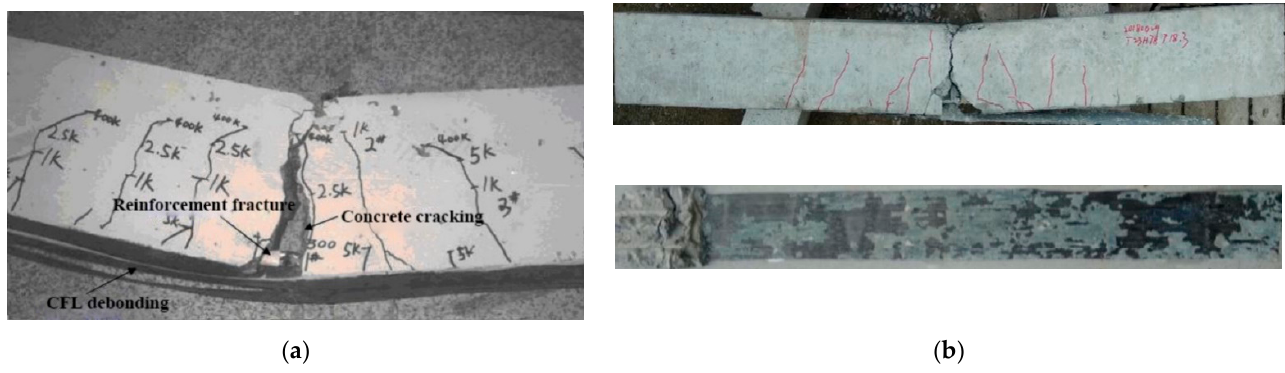
Figure 9. Failure modes of CFL-strengthened RC beam: ( a ) rebar fracture; ( b ) IC debonding fail- ure.